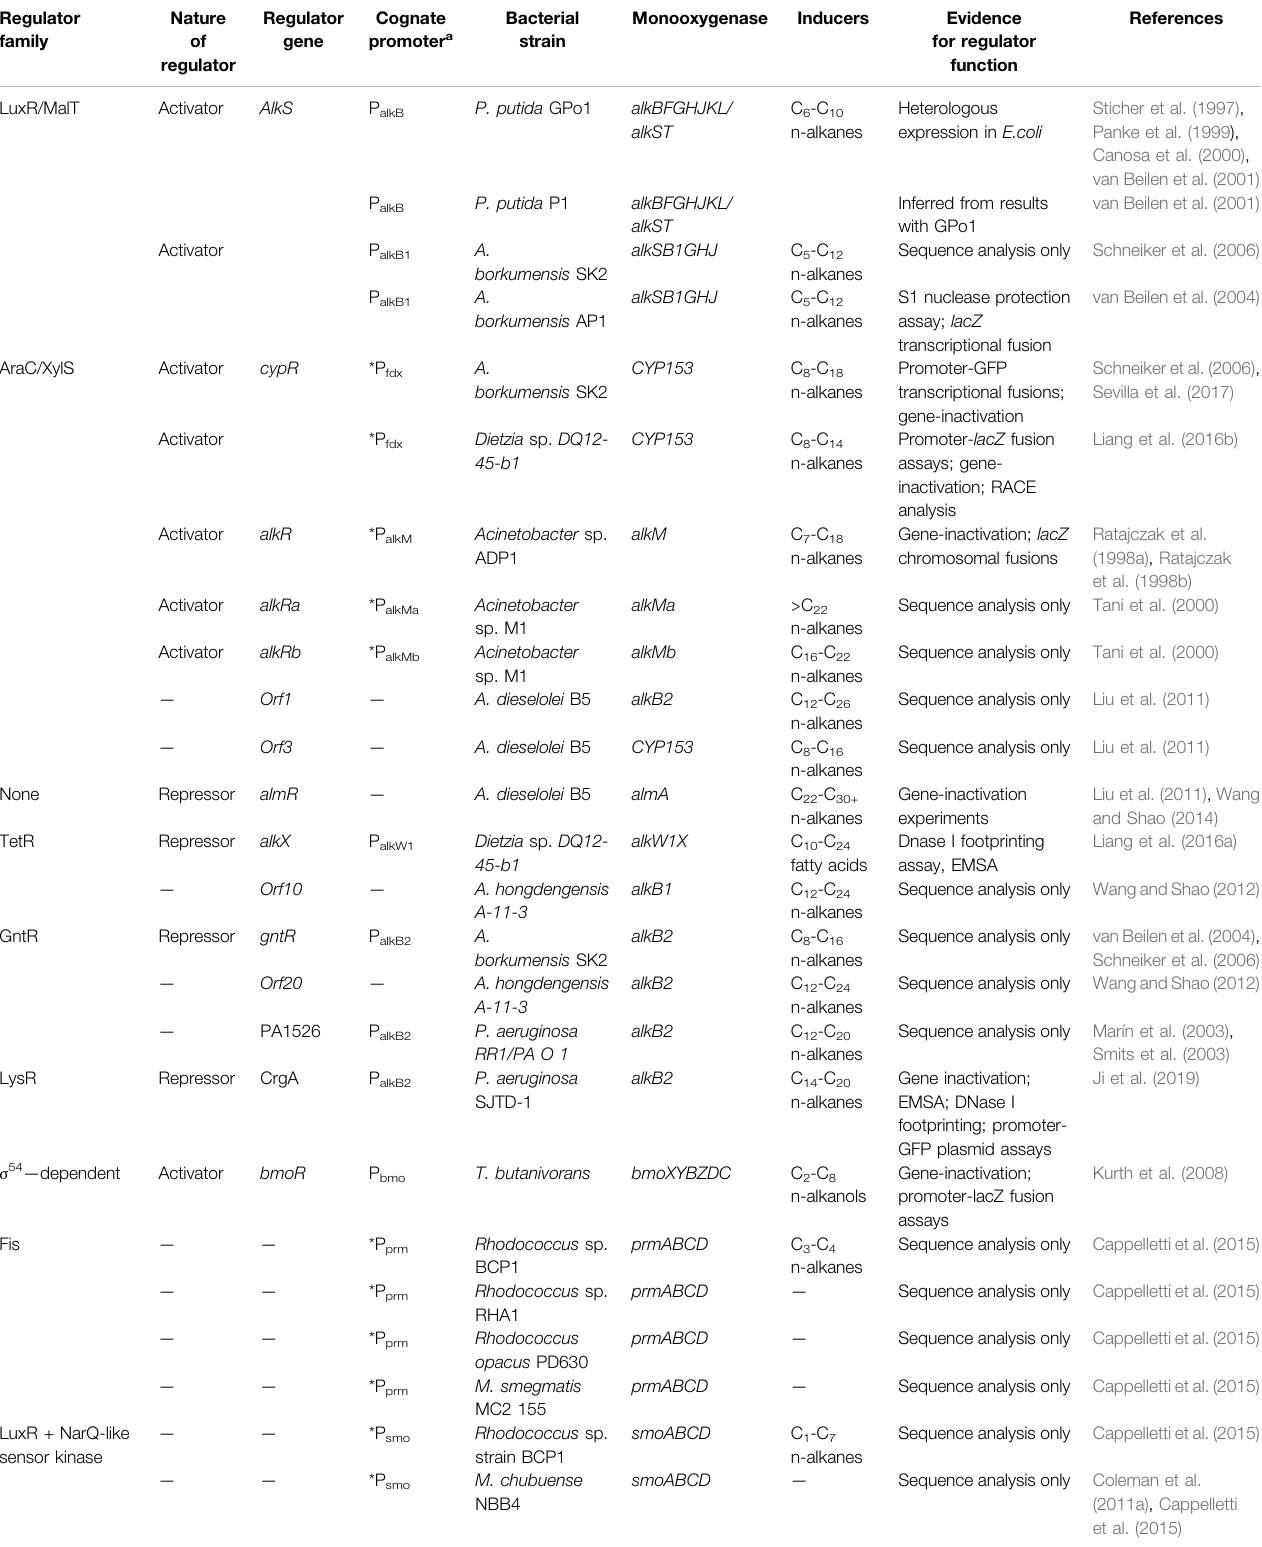
TABLE 4 | Summary of identi fi ed and/or characterised monooxygenase regulatory systems from